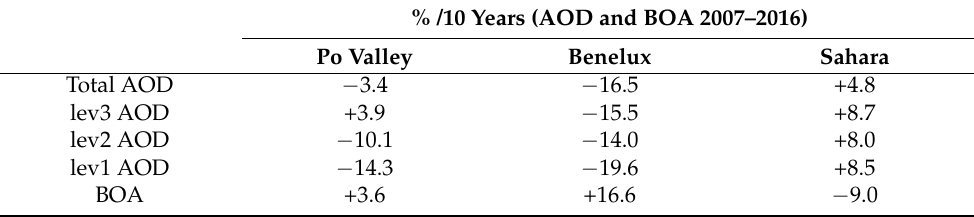
Table 1. Percentage increase/decrease (i.e., +/ − ) per decade of AOD and BOA radiative flux during 2007–2016 calculated on monthly mean values from CALIPSO by using the Theil-Sen slopes (de-seasonalized monthly values). Levels indicate the AOD calculated for lev1: z 0 = 40 m